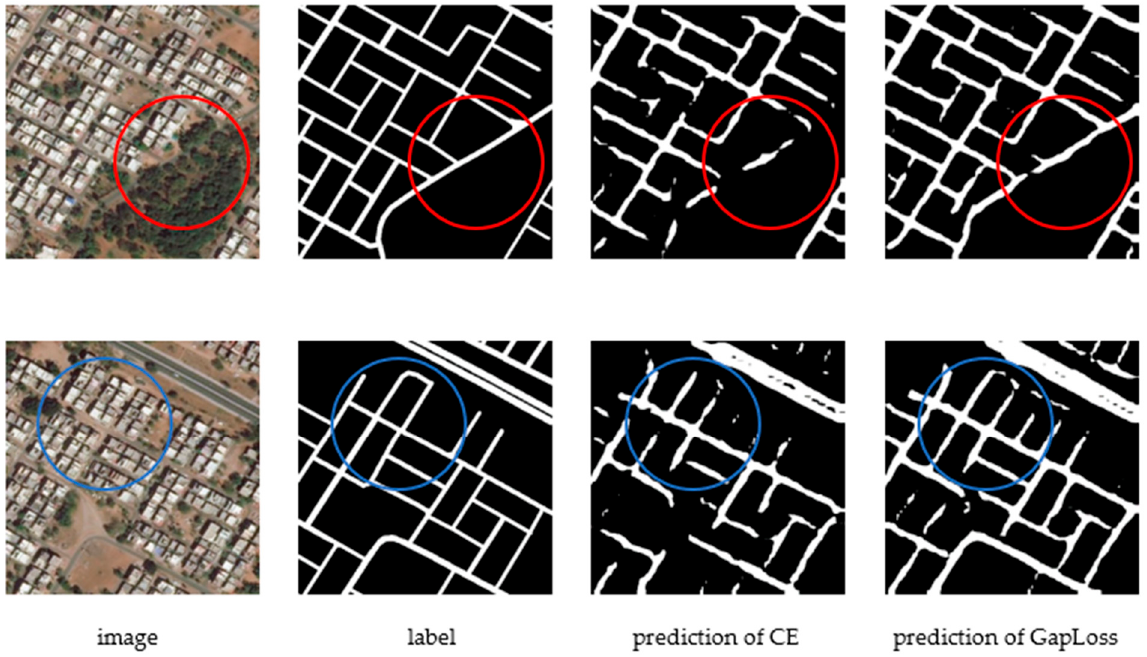
Figure 7. PSPNet results with CE and GapLoss on DeepGlobe Roads Dataset. The blue and red circles indicate where the road continuity is improved after using GapLoss.